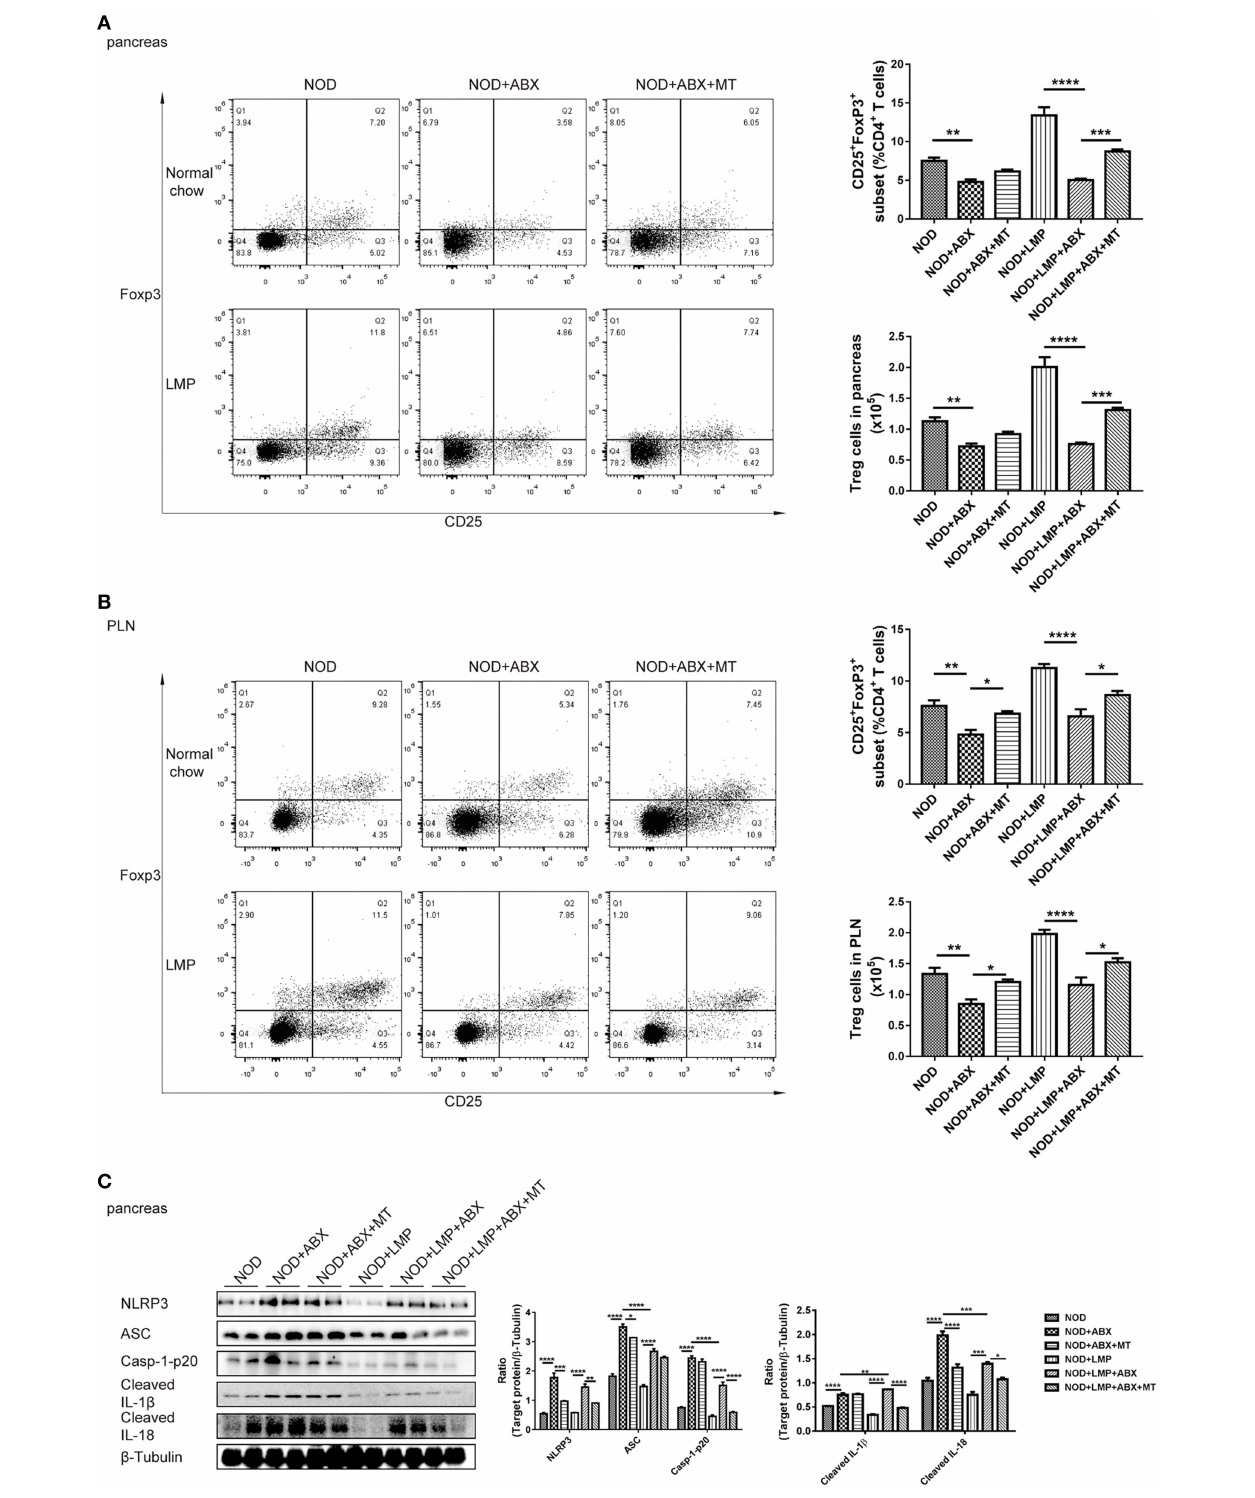
FIGURE 7 | LMP-mediated caecal homeostasis shapes pancreatic immune environment in NOD mice. (A) The frequency of CD25 + Foxp3 + cells in total CD4 + T cells in pancreas was determined by flow cytometry ( n = 6). (B) The frequency of CD25 + Foxp3 + cells in total CD4 + T cells in PLN was determined by flow cytometry ( n = 6). (C) Inflammasome pathway proteins, NLRP3, casp-1-p20, cleaved IL-1 β , and cleaved IL-18 in pancreas were analyzed by Western blot analysis. * p < 0.05; ** p < 0.01; *** p < 0.001, and **** p < 0.0001.